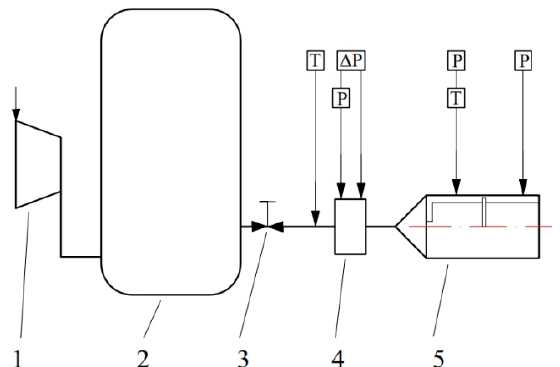
Figure 1. Diagram of the test stand for labyrinth seals, 1 —compressor, 2 —main tank, 3 —regulator valve, 4 —orifice flow meter, 5 —body with the geometry under consideration.